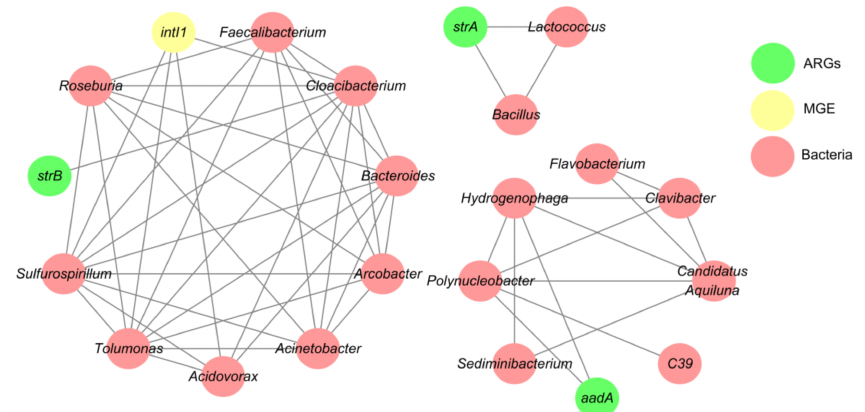
Figure 6. Network analysis showing the co-occurrence patterns based on the intI1 gene, ARGs, and bacterial taxa in the 13 water